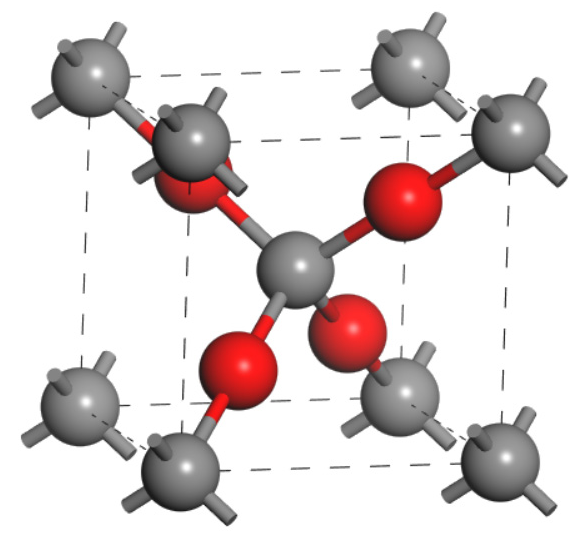
Figure 8. Crystal structure of Cu 2 O.